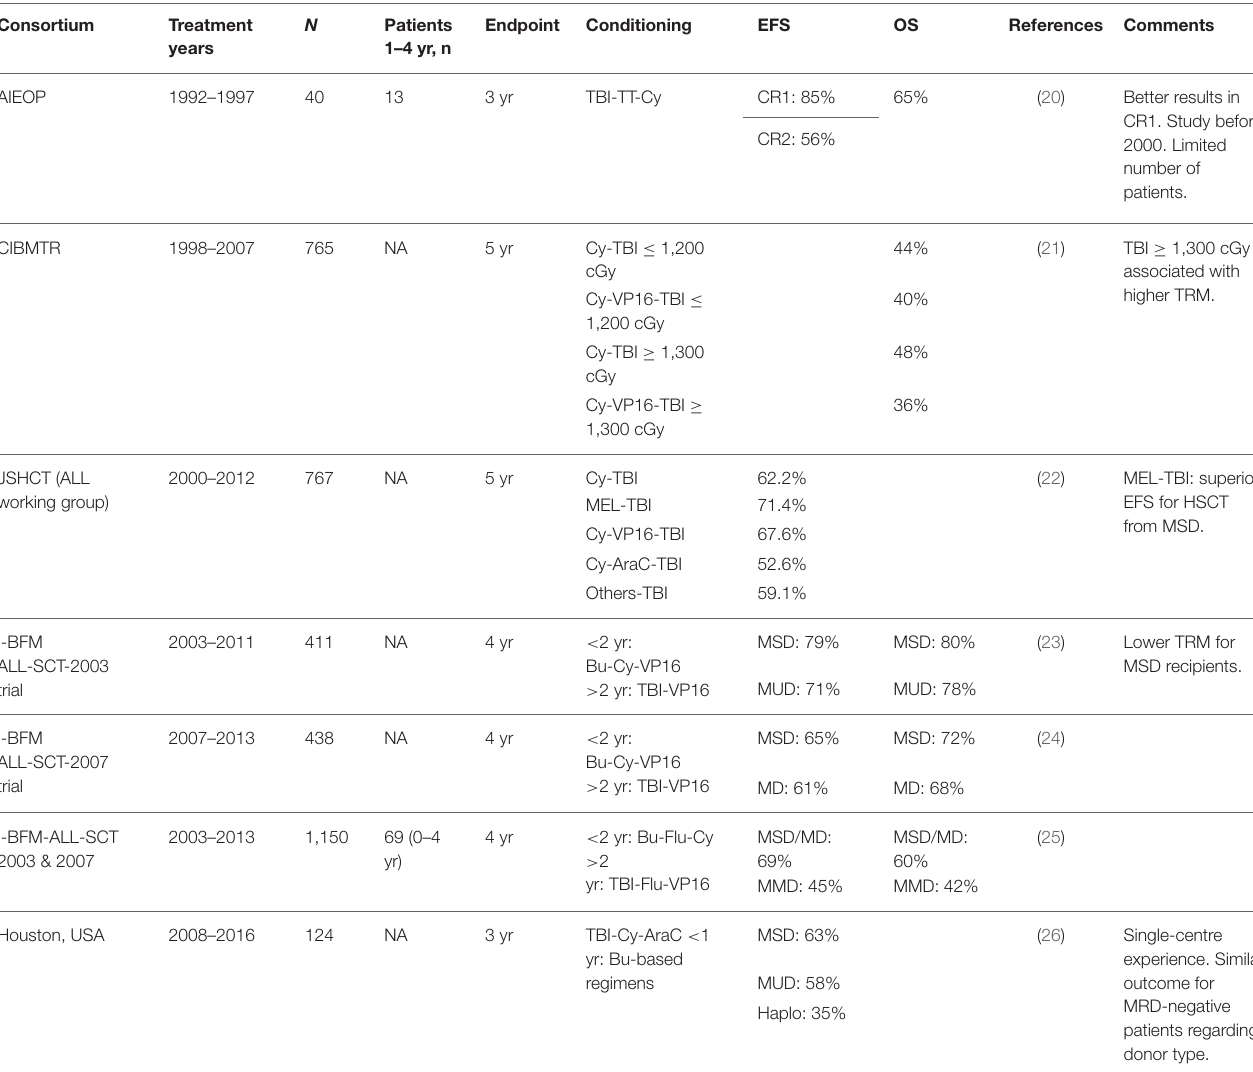
TABLE 2 | Outcome of HSCT after conditioning regimens based on TBI in children with ALL.